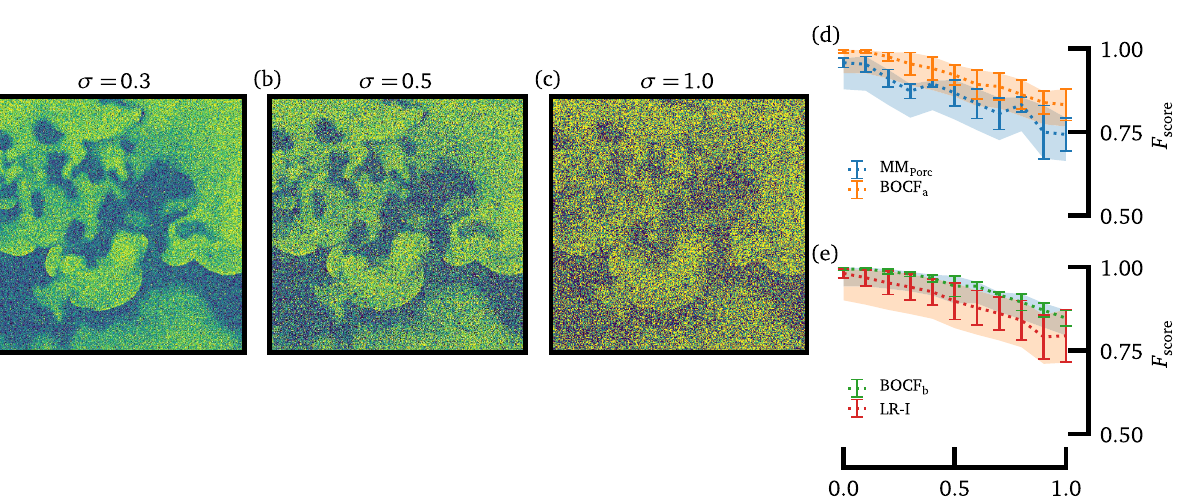
Figure 3. Comparison of spiral wave tips detected by the conventional method (ground truth) and by the UNet. The same exemplary snapshots of the membrane potential V m as in Fig. 1 are shown here for all four cell models (( a – d ), respectively). The positions of spiral wave tips, which were detected by the conventional method are sketched as light gray dots, whereas the positions predicted by the UNet are shown as red crosses. Note, that the samples shown here did not belong to the training data, which was used during the training phase of the UNet. In general, the prediction of spiral wave tips coincides well with the ground truth data. However, in some cases deviations can be observed: In subplot ( d ), a predicted phase singularity (magnified part I) does not correspond to a ground truth PS. In this case, a phase singularity annihilated shortly ( < 10 ms ) before the snapshot was taken. In the second case (magnified part II), a spiral wave front collides with a wave back of a preceding wave, resulting in an abrupt spatial shift of the ground truth phase singularity within a short period of time. In this case, the UNet predicts the position of the PS still at the “former” place. However, within 10ms after the shown snapshot, the ground truth position and the predicted position of the PS coincide again.